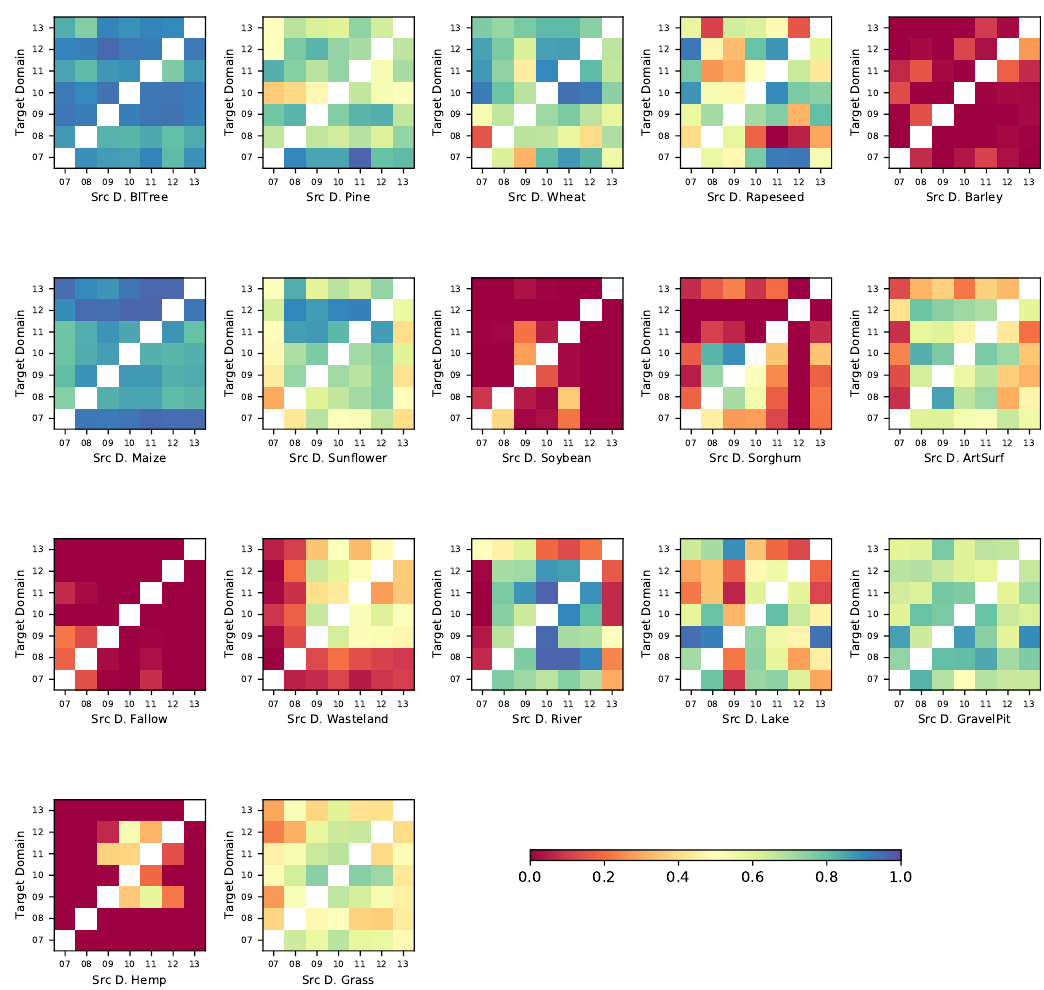
Figure 6. FScore of each class obtained in naive baseline. Each heat map corresponds to a class showing the results combining the various possible pairs of years. The diagonal represents the supervised case, so the values are set to 0. Source domain year and class are indicated on the x-axis, the target domain year on the y-axis. The color scale shows the difference range, with a low FScore value in red and very high FScore in